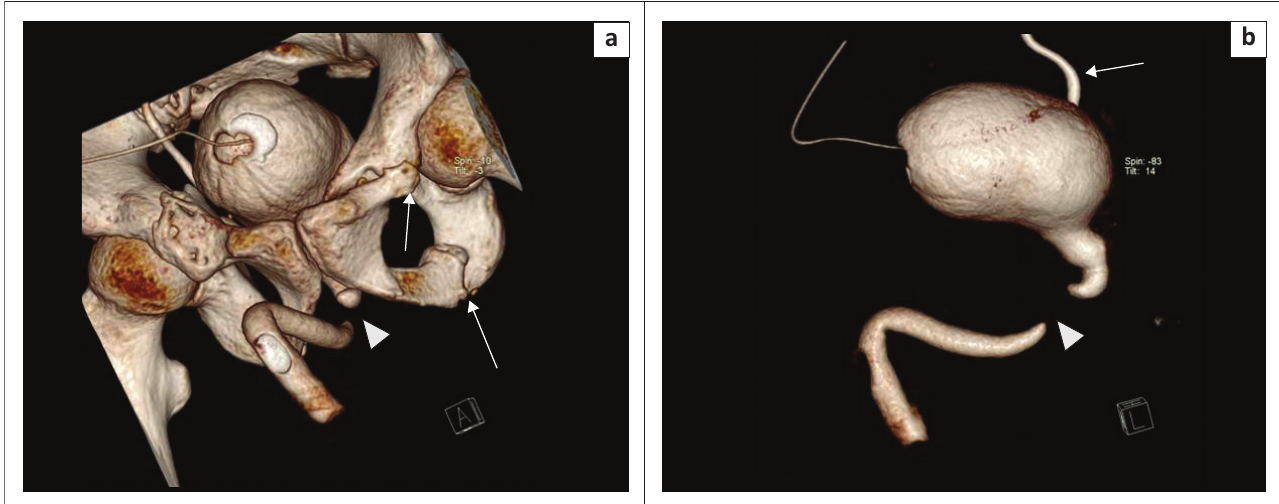
FIGURE 9: Volume rendered technique image (a) before bone removal and (b) after bone removal, showing the posterior urethral distraction defect (arrowhead) at the level of the membranous urethra. The part of the urethra proximal to the defect is dilated. Right-sided vesico-ureteric reflux (VUR) (arrow) and the fractures of bilateral superior pubic rami and left inferior pubic rami (arrows) are